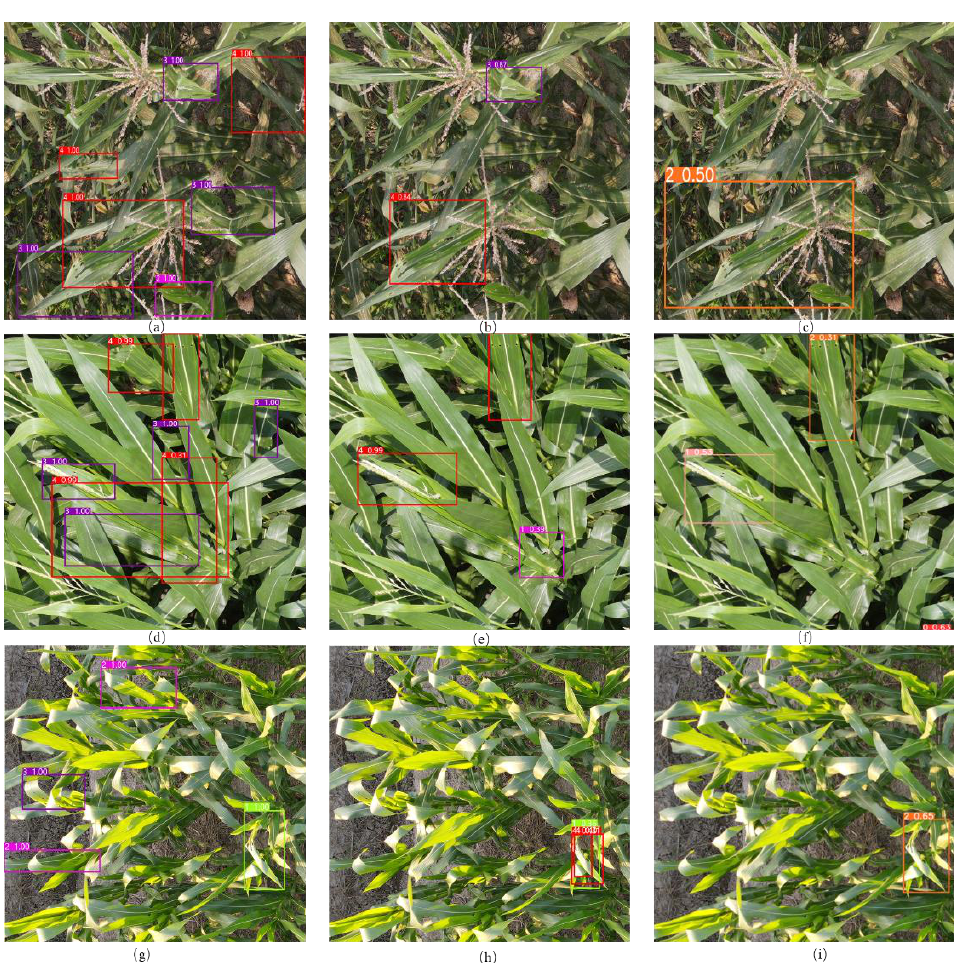
Figure 14. Anchor boxes predicted by Pest R-CNN, the original Faster R-CNN, and YOLOv5. ( a , d , g ) The predicted results of the Pest R-CNN; ( b , e , h ) shows the predicted results of the original Faster R-CNN; ( c , f , i ) shows the results of the YOLOv5. The first number outside the anchor is the severity degree: 0, 1, 2, and 3 stand for juvenile, minor, moderate, and severe, respectively, and the second number is the classification confidence.